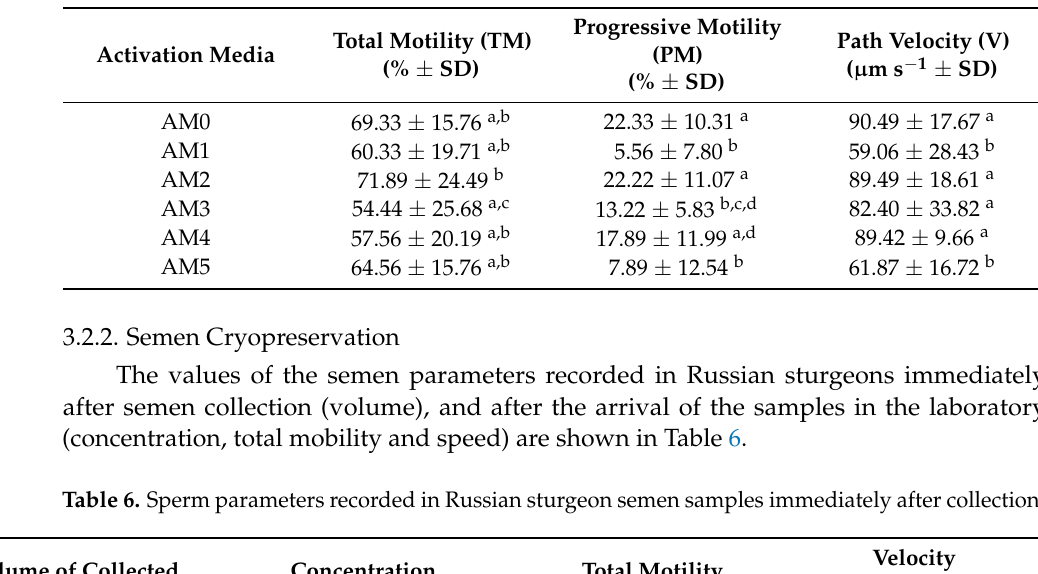
Table 5. The motility parameters according to the different semen activation media. Different letters on table columns indicate significant differences ( p